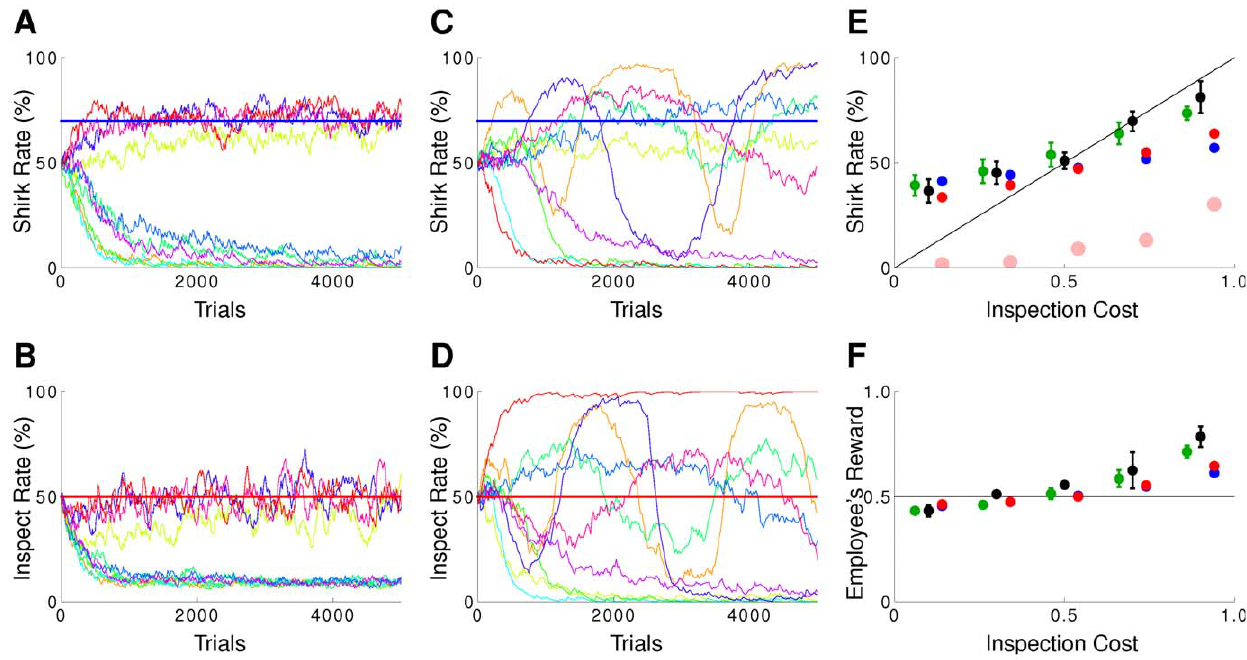
Figure 4. Covariance learning rules may lead to a mixed Nash equilibrium, but also to deterministic non-Nash strategies. pRL fits data better than basic reinforcement models. Time course of the probability to shirk (A,C) and inspect (B,D) with inspection cost i ~ 0 : 7 for pCOV vs algorithm (A,B) and pCOV vs pCOV (C,D). In each panel the horizontal lines depict the Nash equilibrium, and for 10 simulation runs inspection and shirk rates are shown (same color in (A,B) and (C,D), respectively, correspond to the same run). Only a small fraction of all runs converge or oscillate around the Nash equilibrium, while the other runs result in a deterministic strategy pair. The initial distribution of synaptic weights w was Gauss with mean 0 and standard deviation 0 : 02 . The learning rate was set to g ~ 0 : 004 , but g ~ 2 : 10 { 7 did not change the proportion of runs converging to the pure strategy. (E) Average choice behavior of pRL vs pRL (green), RE1 vs RE1 (blue), RE3 vs RE3 (red) and human vs human (black) for 150 trials/block as function of the inspection cost. The light red circles show the average choice behavior for RE3 vs RE3 and 5000 trials/ block. Individual runs converged to a pure strategy, hence the shown averages over 200 runs reflect the percentage of runs converging to a pure shirk strategy. (F) Reward as function of the inspection cost for 150 trials/block. Coloring as in (E). The solid lines indicate the Nash